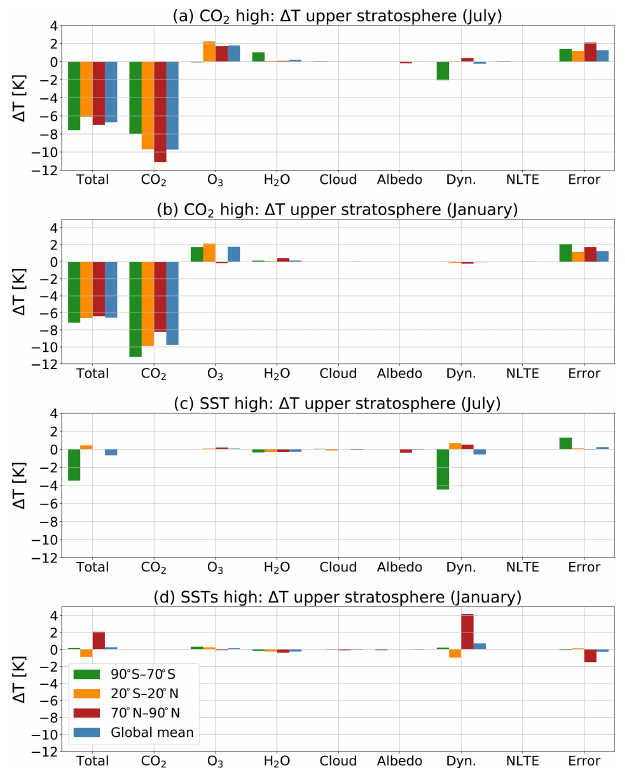
Figure 13. The mean temperature responses to the changes in CO 2 , and various feedback processes in July (a, c) and January (b, d) in the upper stratosphere between 24 and 1hPa for polar regions (90– 70 ◦ S and 70–90 ◦ N), the tropics (20 ◦ S–20 ◦ N) and the global mean for the experiment with double CO 2 (S1) (a, b) and changed SSTs (S2) separately (c, d)